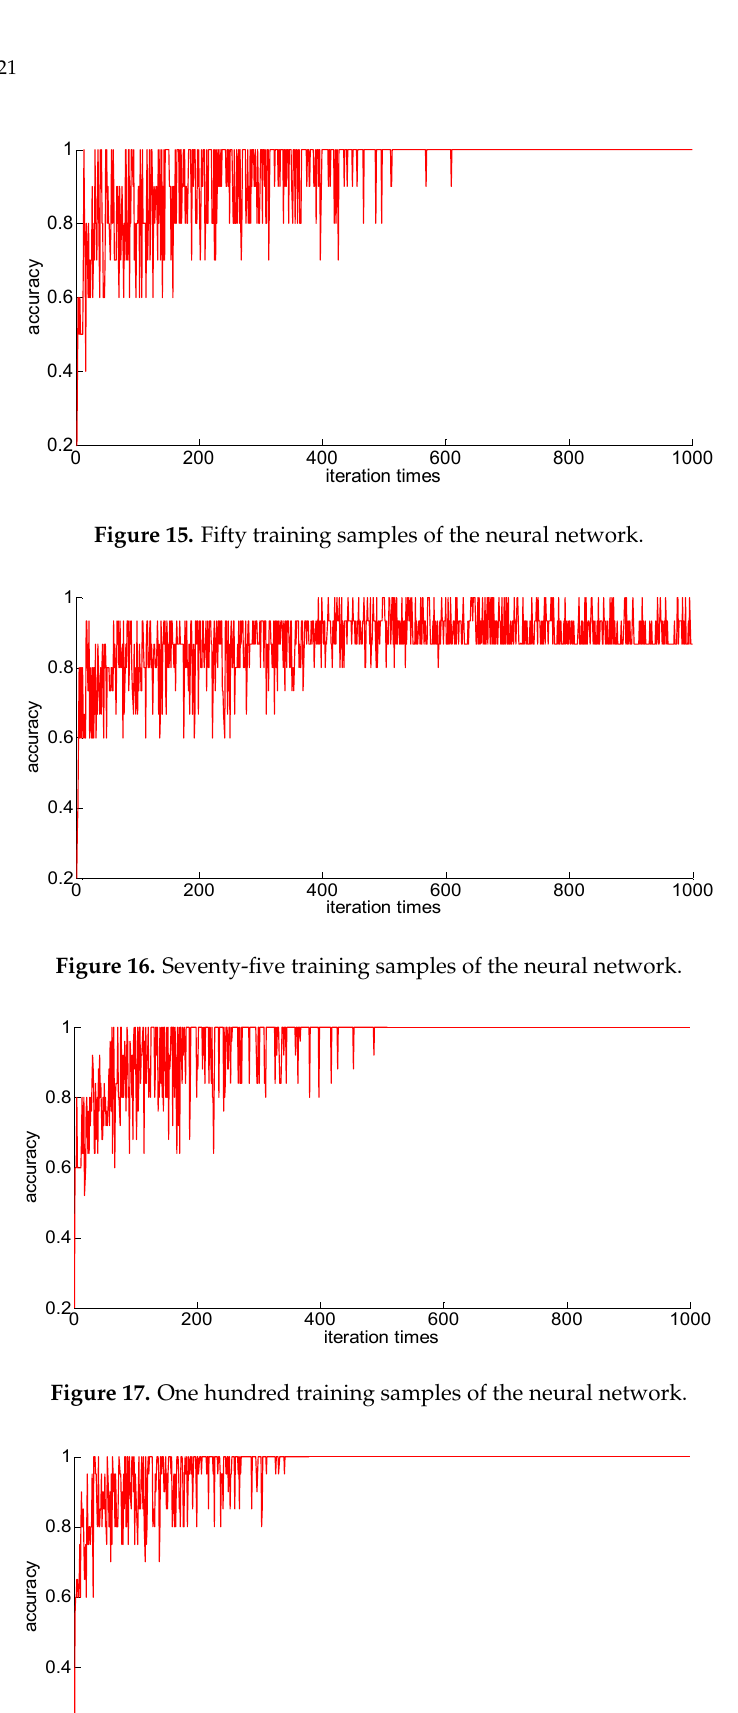
Table 11. New features based on skewness factor fusion. New Feature